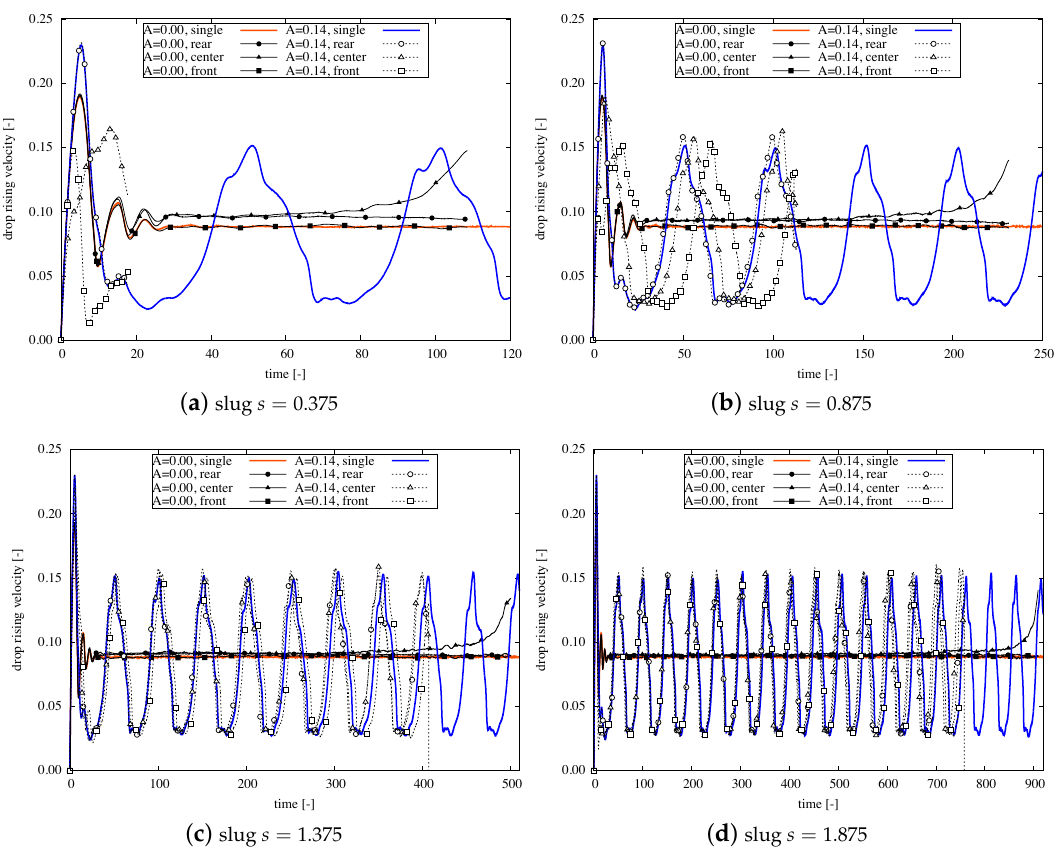
Figure 8. Center of mass rising velocity as function of time for drops in channels with amplitudes A = 0.00 (straight channel, red color) and A = 0.14 (sinusoidal, blue color). The figures stand for different drop’s distance compared to single drop simulations with initial liquid slug length: ( a ) s = 0.375, ( b ) s = 0.875, ( c ) s = 1.375, and ( d ) s = 1.875. All parameters are